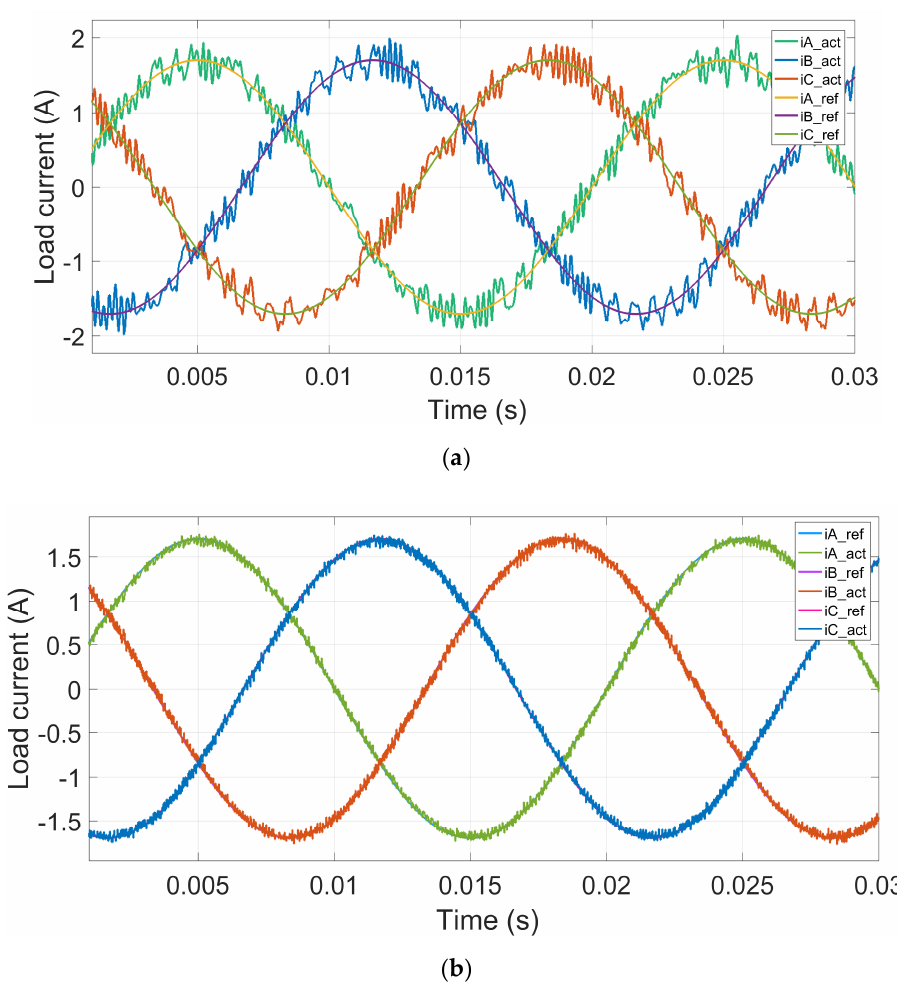
Figure 17. The load current waveforms of the two-level three-phase VSI: ( a ) using hysteresis current control ( b ) using FS-PDCC control.